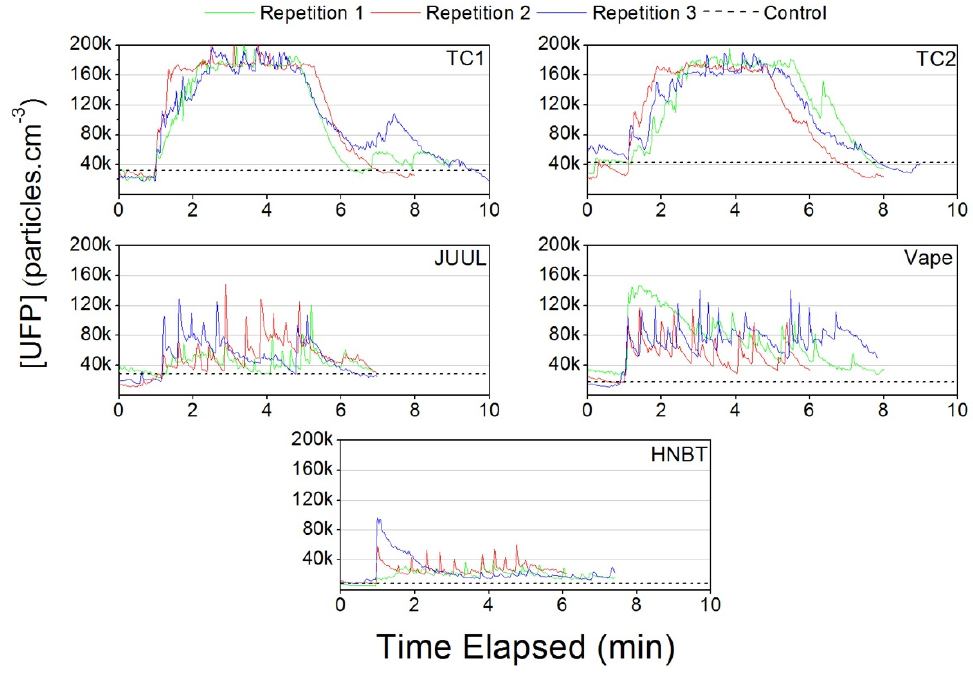
Figure 7. Ultrafine particle concentrations measured in the car during traditional cigarette (TC1 and TC2), e-cigarette (JUUL and Vape) and heat-not-burn tobacco (HNBT) consumption.